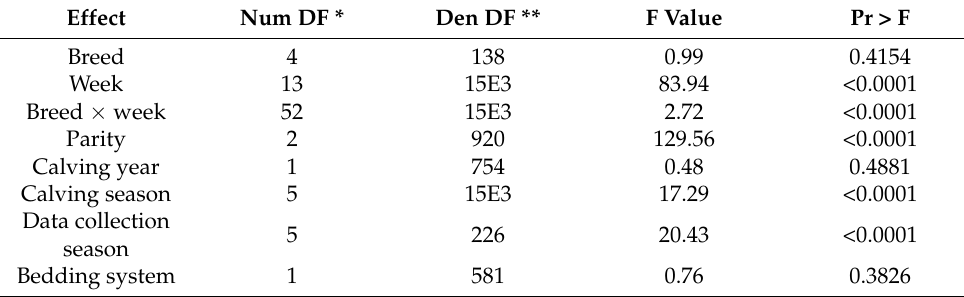
Table A8. Variance analysis results for the variable milk yield.